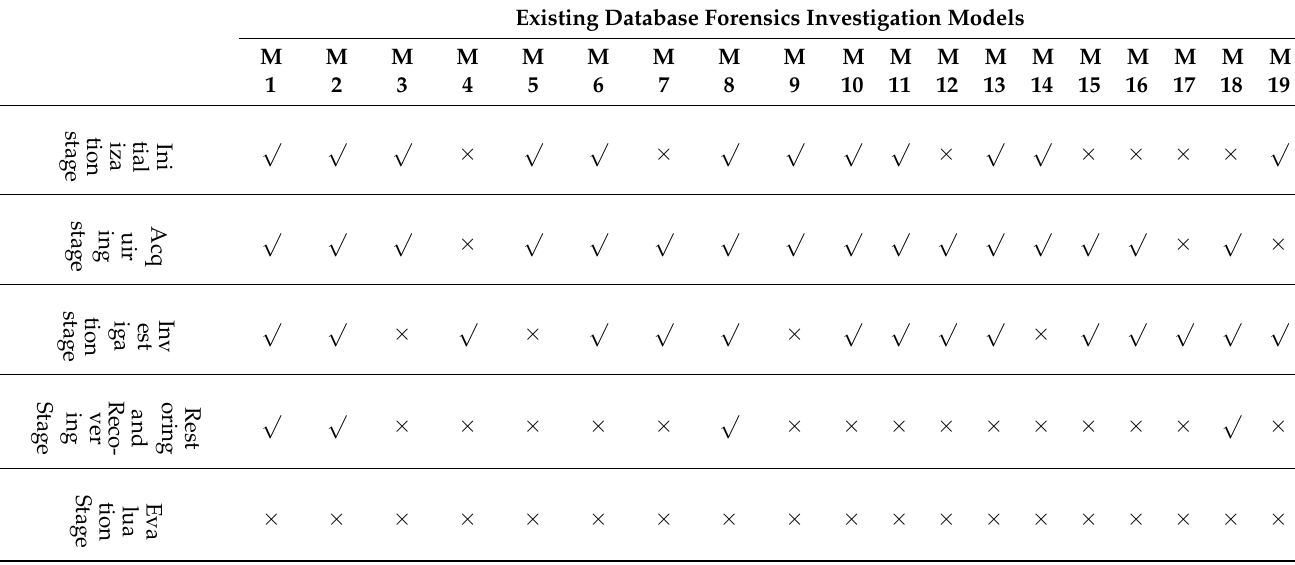
Table 3. Comparison between exiting DBFI models with the proposed model. Existing Database Forensics Investigation